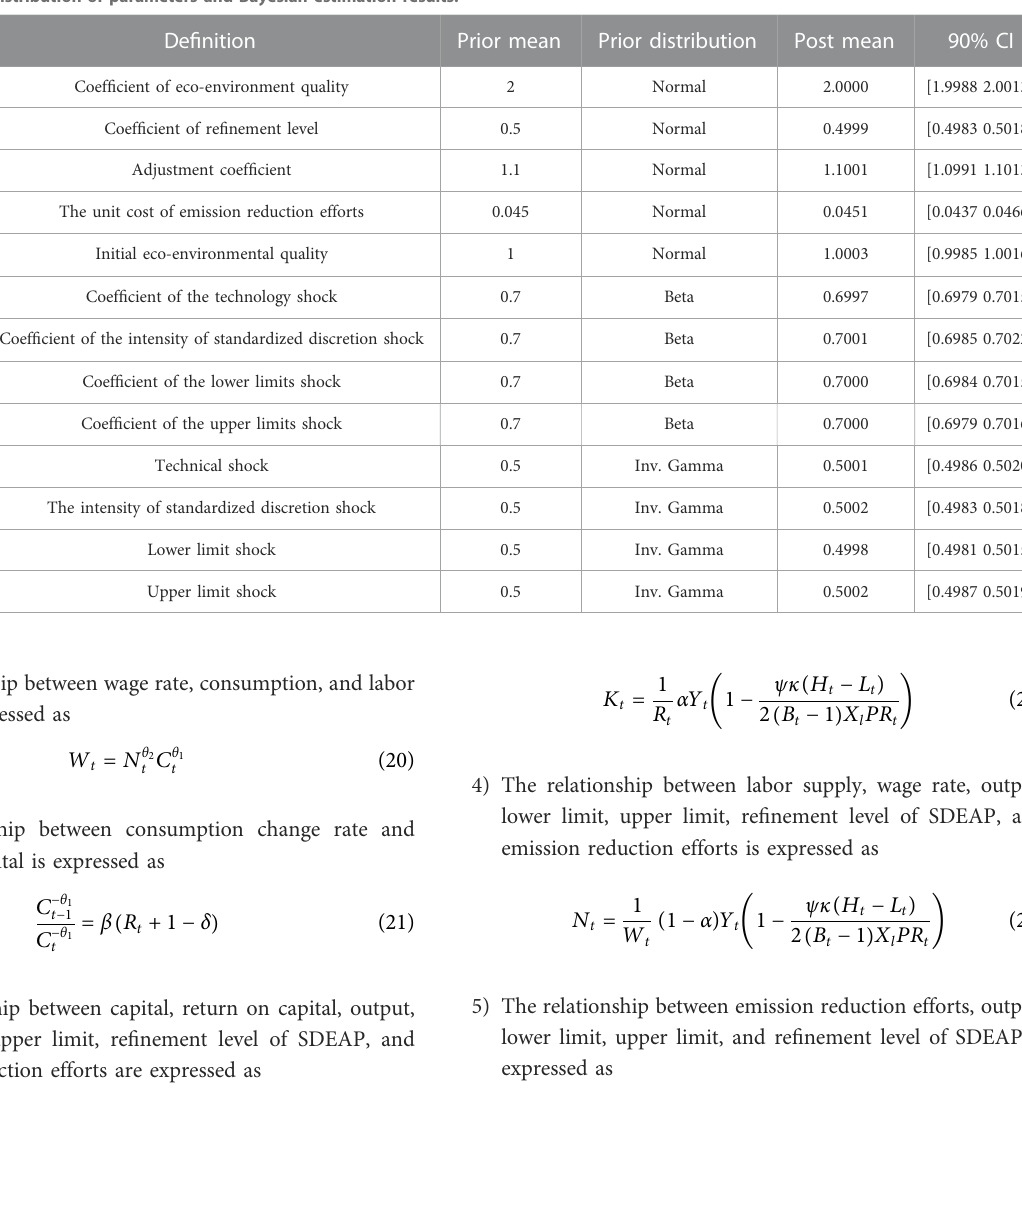
TABLE 7 The prior distribution of parameters and Bayesian estimation